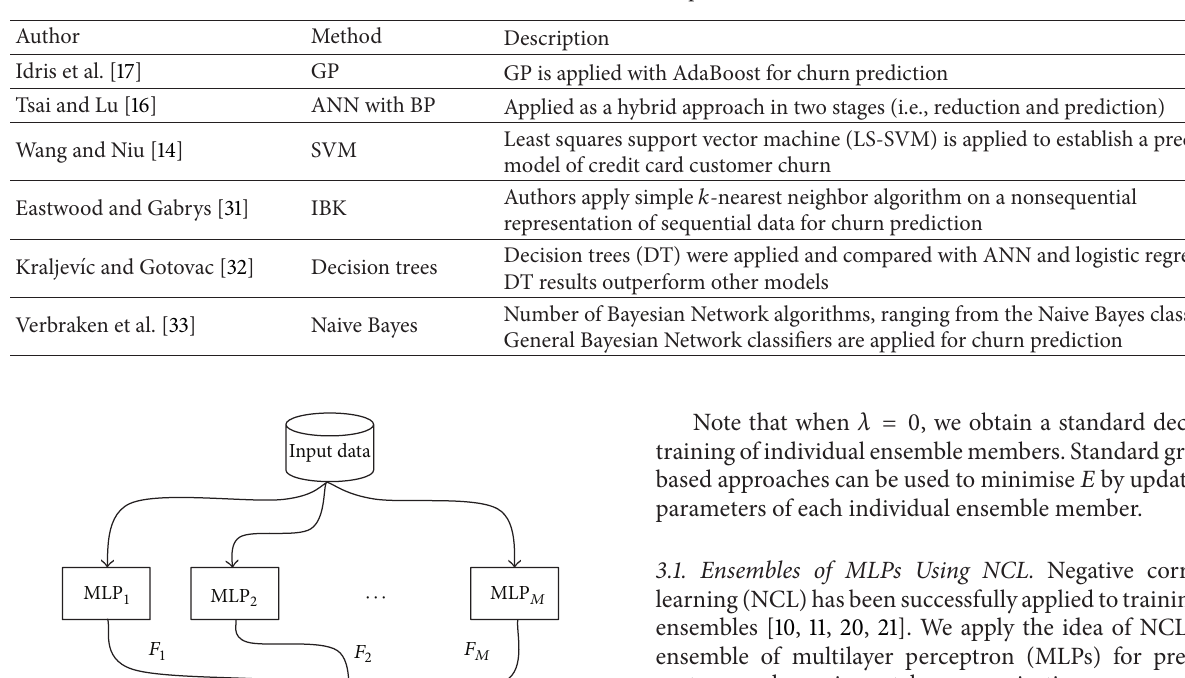
Table 1: Related work for churn prediction methods.